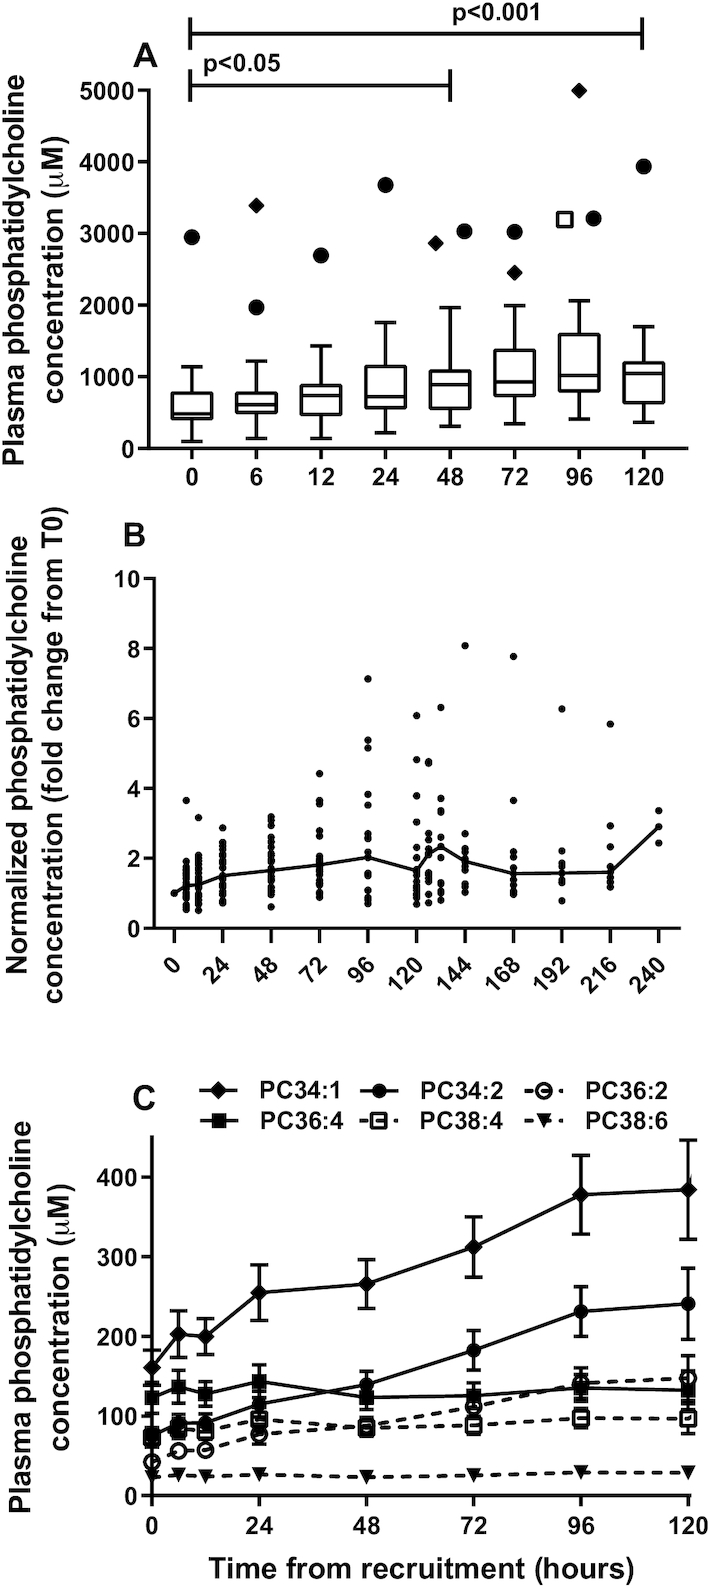
Concentration of plasma PC in preterm infants. (A) PC concentration increased with time from recruitment and exhibited considerable variation. Results are shown as a box-and-whisker plot with medians, IQRs. The symbols above the box-and-whisker plots represent outlier values. Each symbol refers to 1 of 3 of the same infants who had high concentrations of plasma PC. Significance was assessed using the Mann-Whitney test. (B) PC concentration from time of recruitment for individual infants, expressed relative to the initial value at t = 0 h. (C) Concentrations of selective PC molecular species over the first 5 d of the study. Results are expressed as means ± SEMs. Numbers of infants decreased at each time point from 31 at t = 0 to 23 at t = 120 h. PC, phosphatidylcholine.